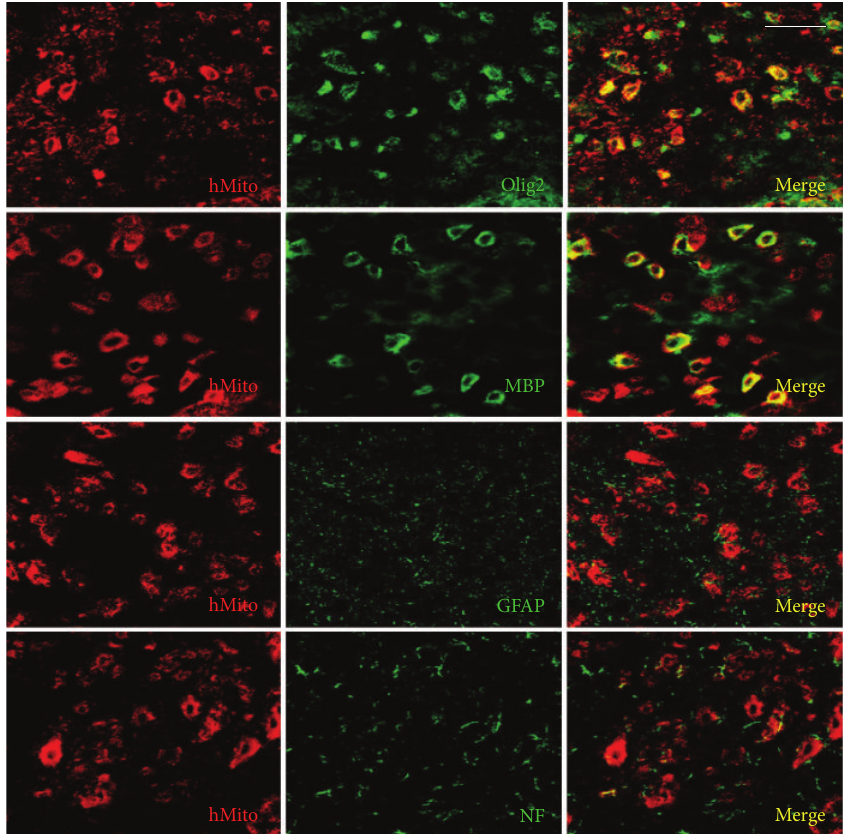
Figure 6: Differentiation of transplanted human (hMito-positive) F3.olig2 cells into oligodendrocytes (Olig2-positive), astrocytes (GFAP- positive), or neurons (NF-positive) and maturation to MBP-positive oligodendrocytes. Olig2: oligodendrocyte transcription factor, MBP: myelin basic proteins, GFAP: glial fibrillary acidic proteins, and NF: neurofilaments. Bar = 25 𝜇 m.